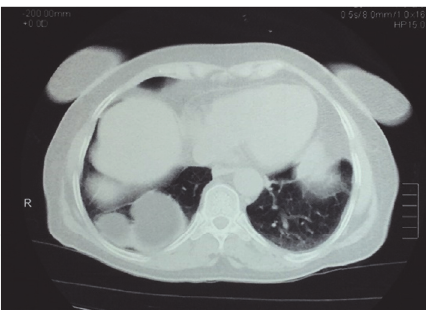
Figure 4: Contrast-enhanced CT scan showed right diaphragmatic hernia.